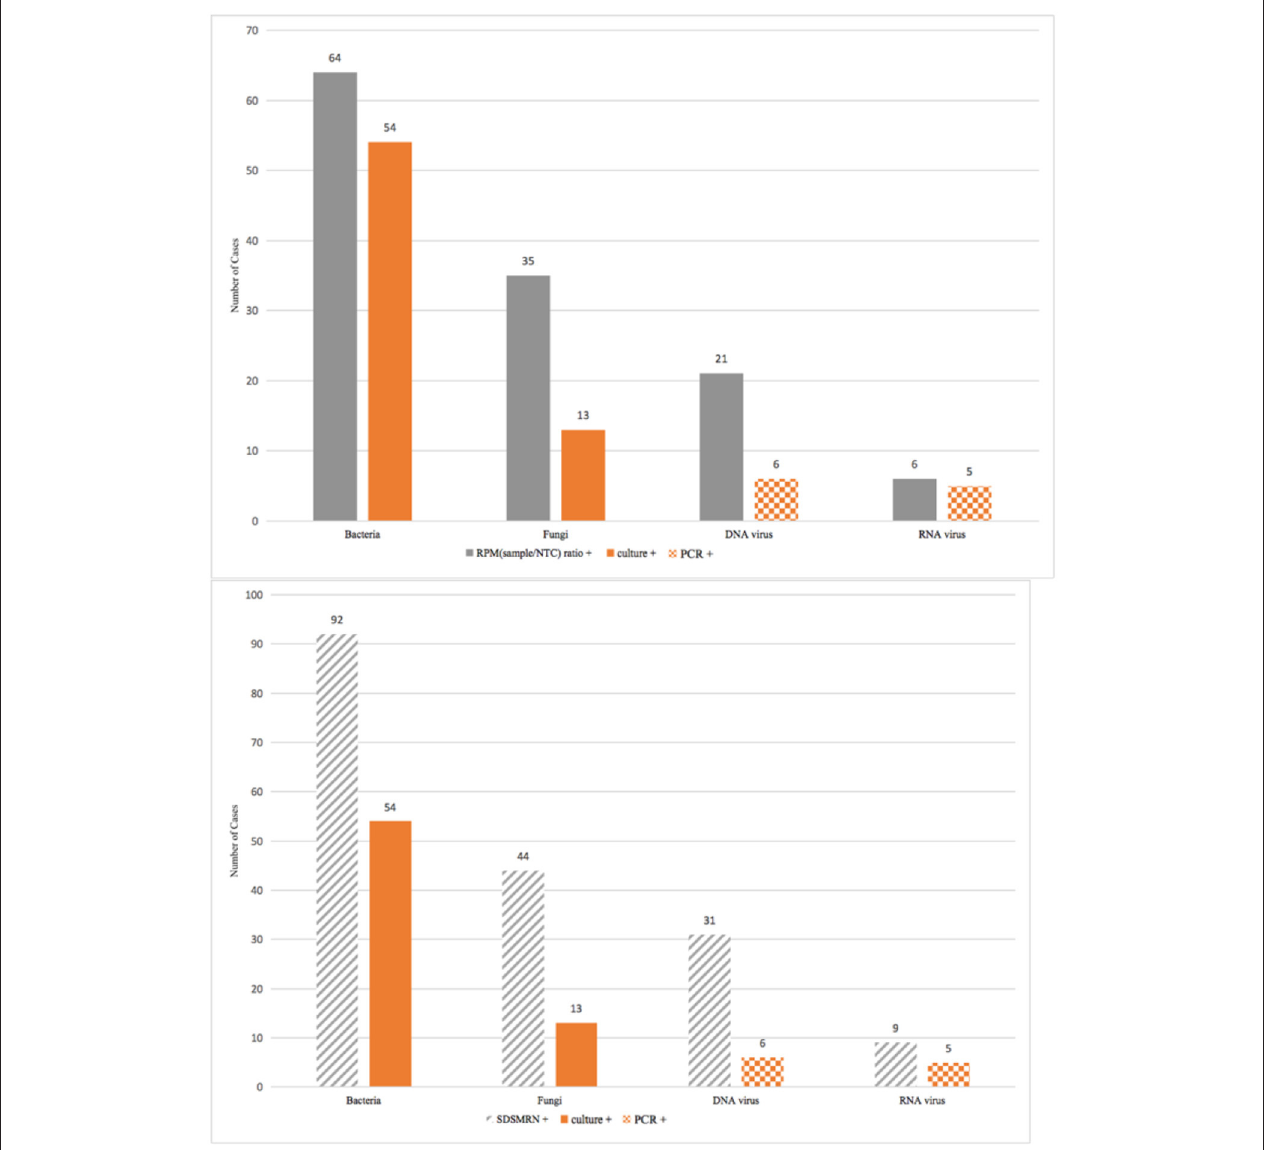
FIGURE 4 | Positive cases identified by metagenomic sequencing or conventional microbiology tests (culture/PCR) from a total of 149 patients counted to the final